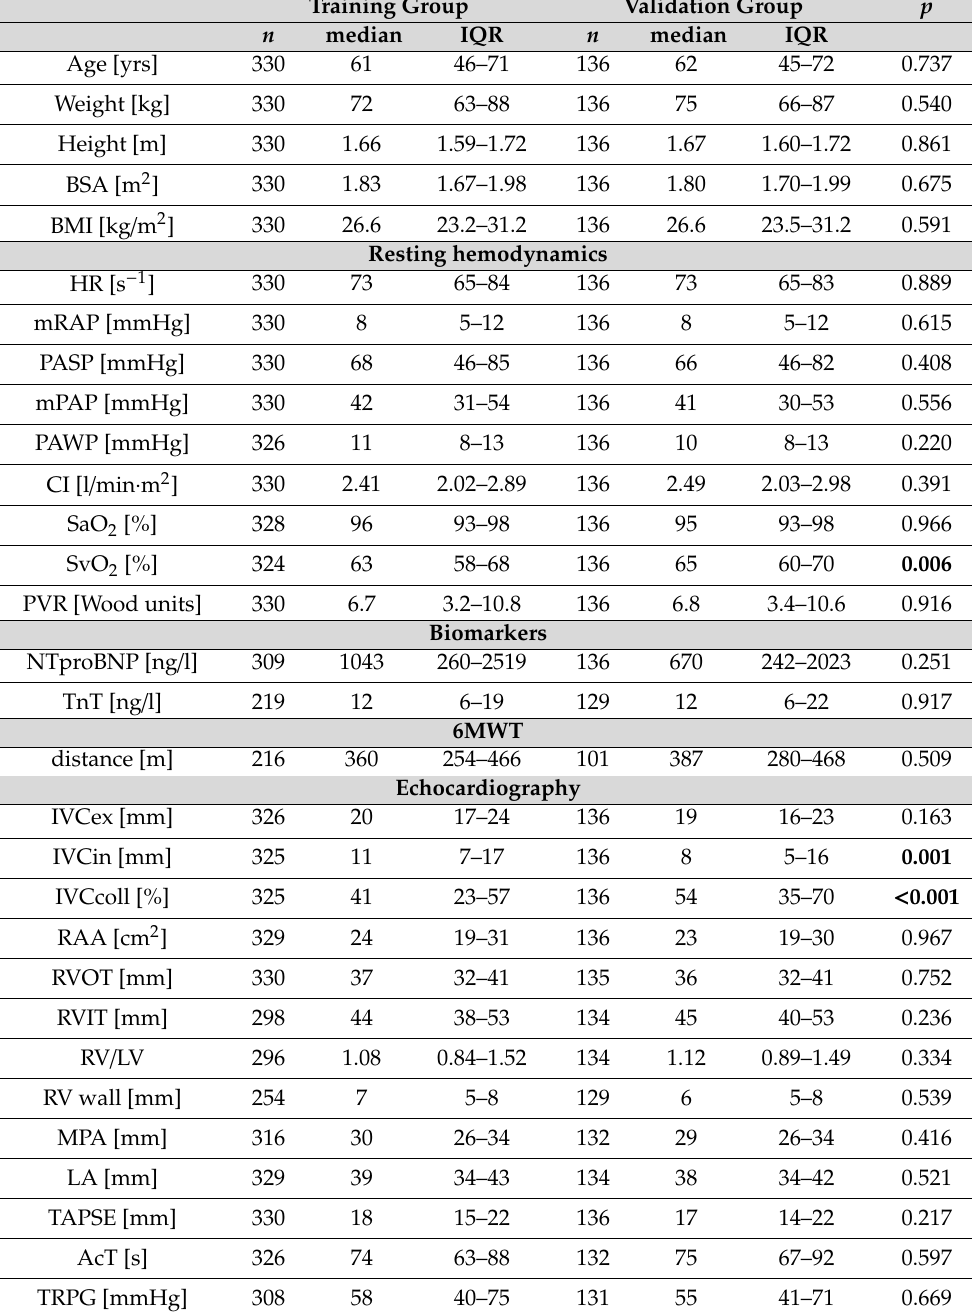
Table 3. Baseline characteristics—continuous variables (number, median, interquartile